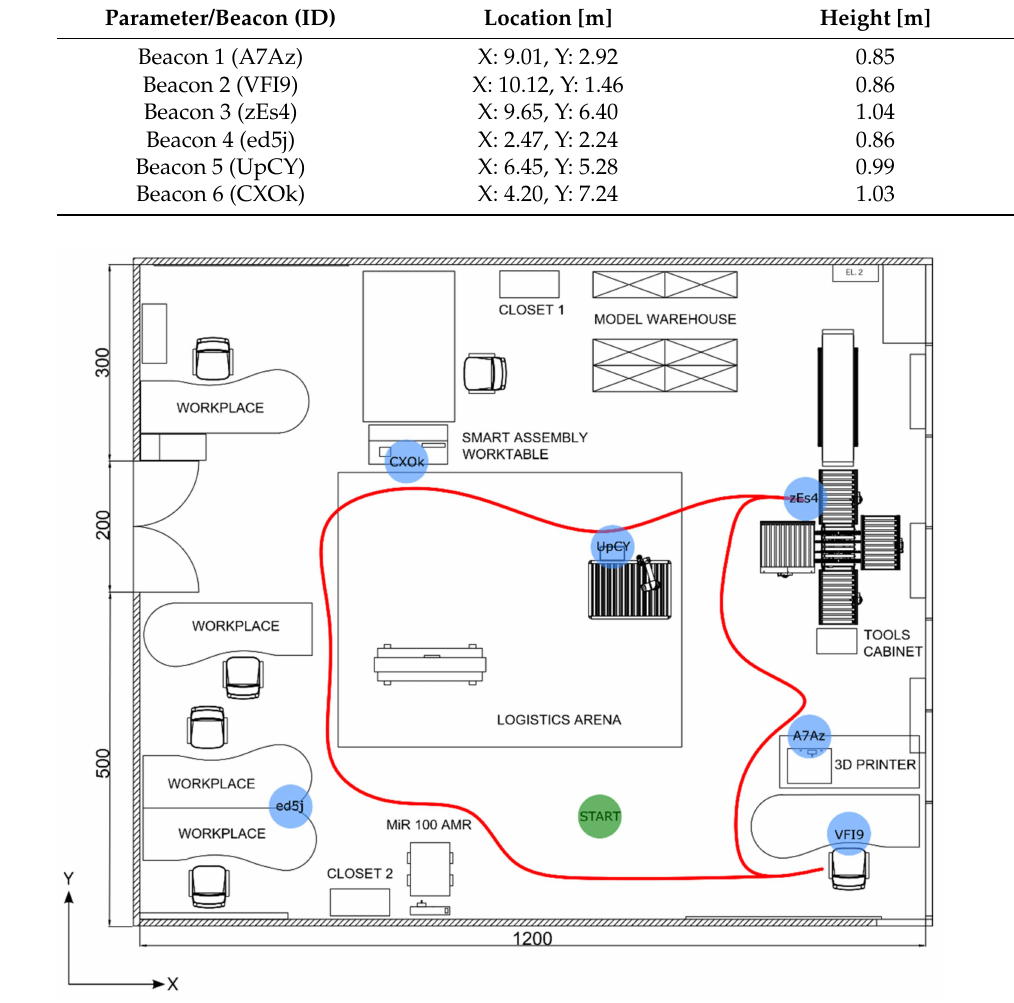
Figure 10. Layout of the test setting in the Laboratory for Cognitive Systems in Logistics. The red line indicates the path of the person performing the experiments. The blue circles represent the used